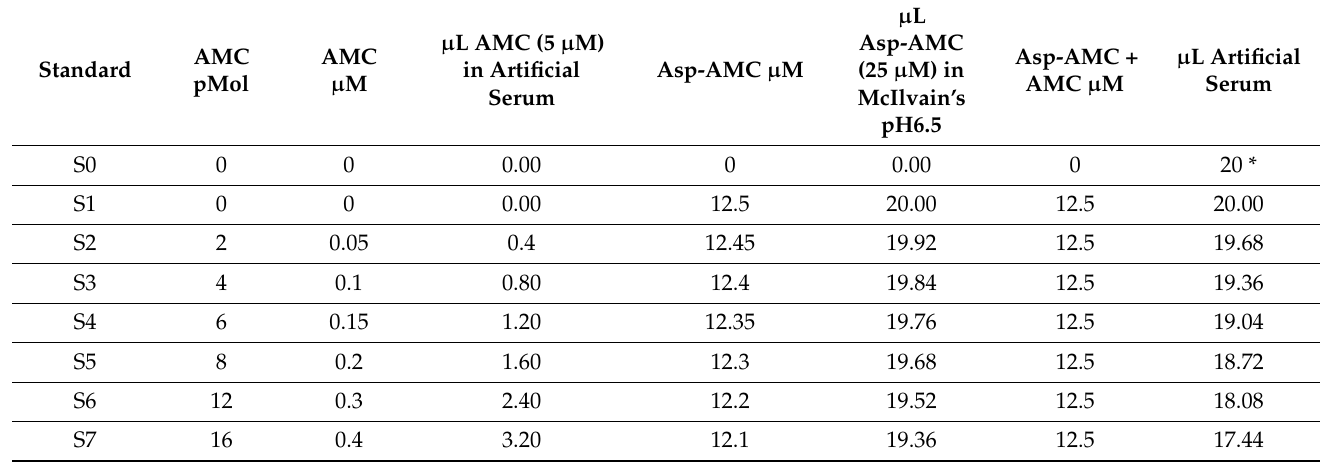
Table 1. Pipetting scheme for calibration